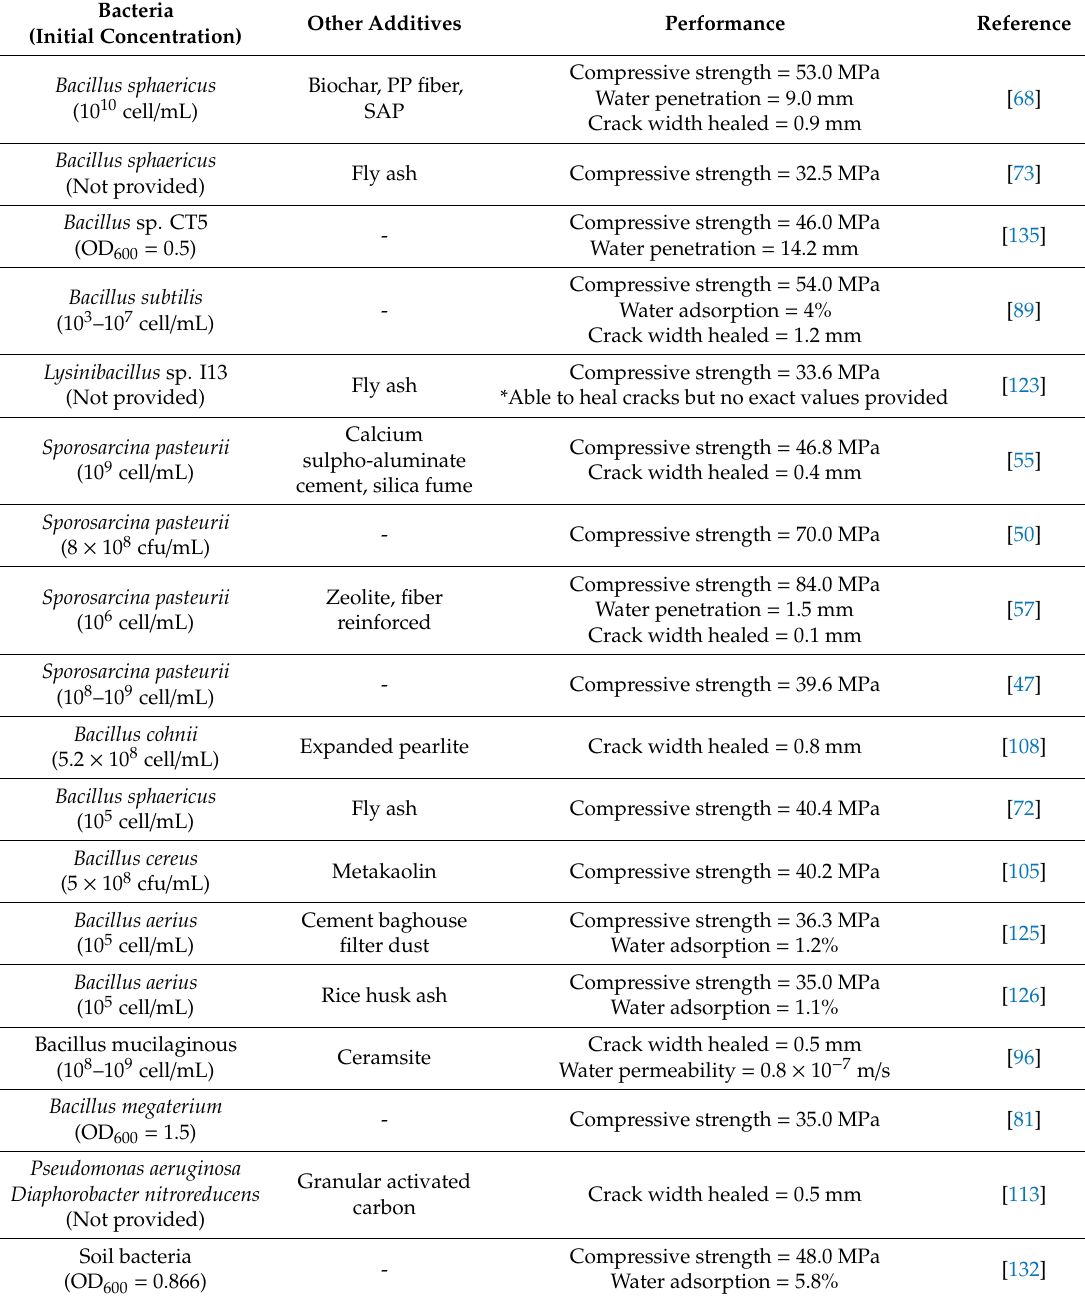
Table 7. Performance of MICP by various bacteria in making concrete and